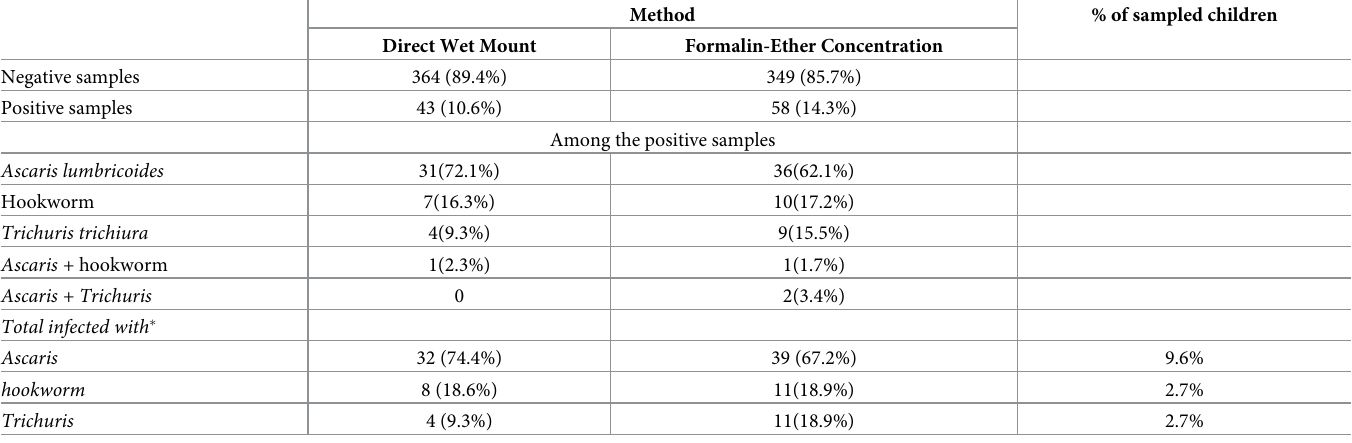
Table 3. Prevalence of geohelminthiasis among the children in Kota Marudu. Presence of geohelminths was detected by direct wet mount and formalin-ether concen- tration methods. Sample size = 407.